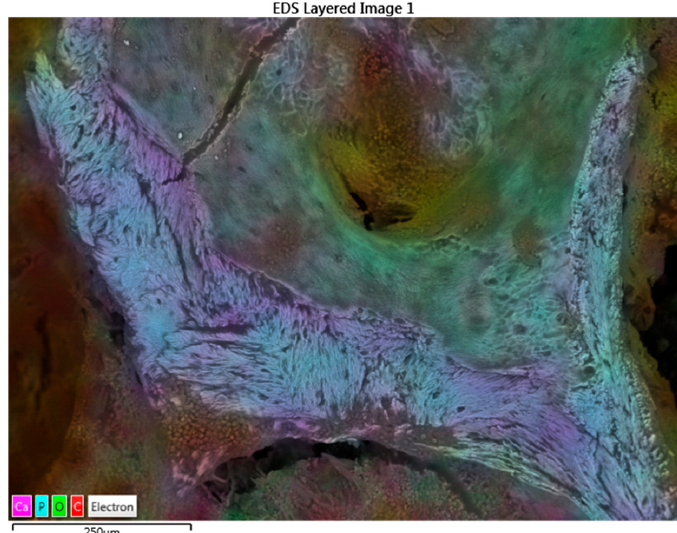
Figure 5. SEM-EDX map factor of the T0 sample. The map factor allowed us to observe the distri- bution of the Ca, P, O, and C electrons that compose the bone. Samples T1 and T2, comprising the group in which all the preparation sites were carried out with cutters used from the first cycle to a maximum of 10 cycles of use and sterilization, show no metal residues due to preparation (Figure 6). Samples T3 and T4 showed small fields of residues (Figure 7), the presence of which increased in samples T5 and T6, which have undergone 30 to 50 cycles of use.